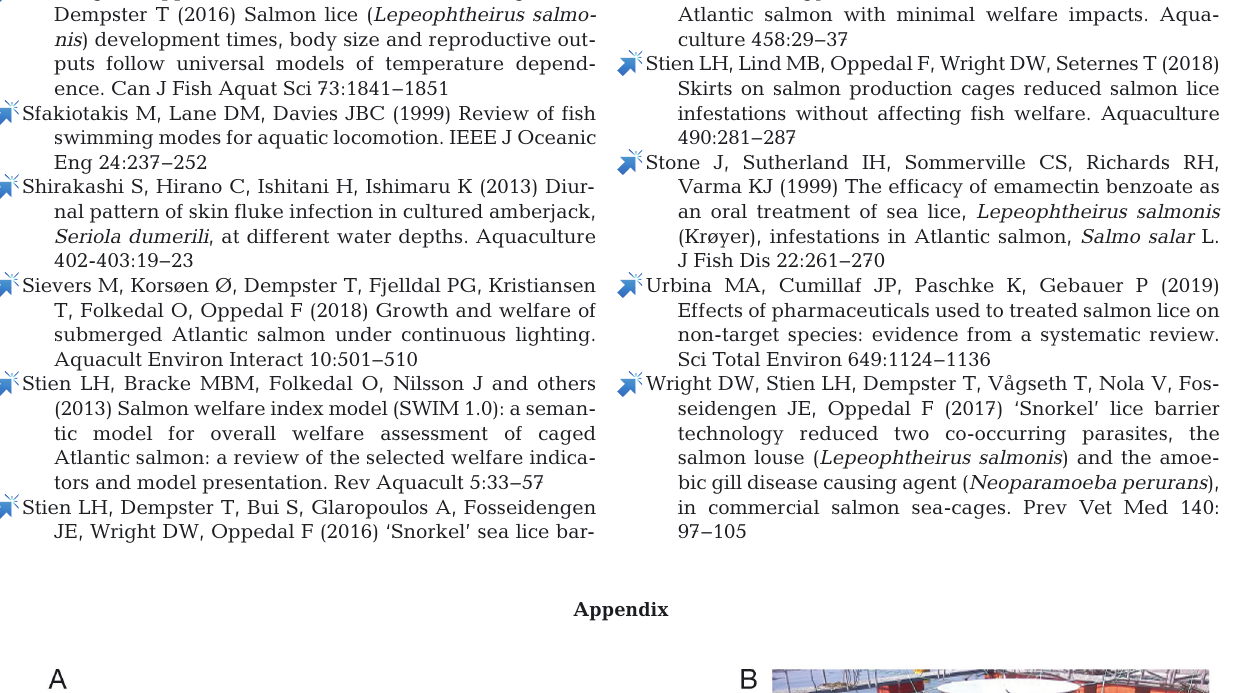
Editorial responsibility: Bengt Finstad, Trondheim,